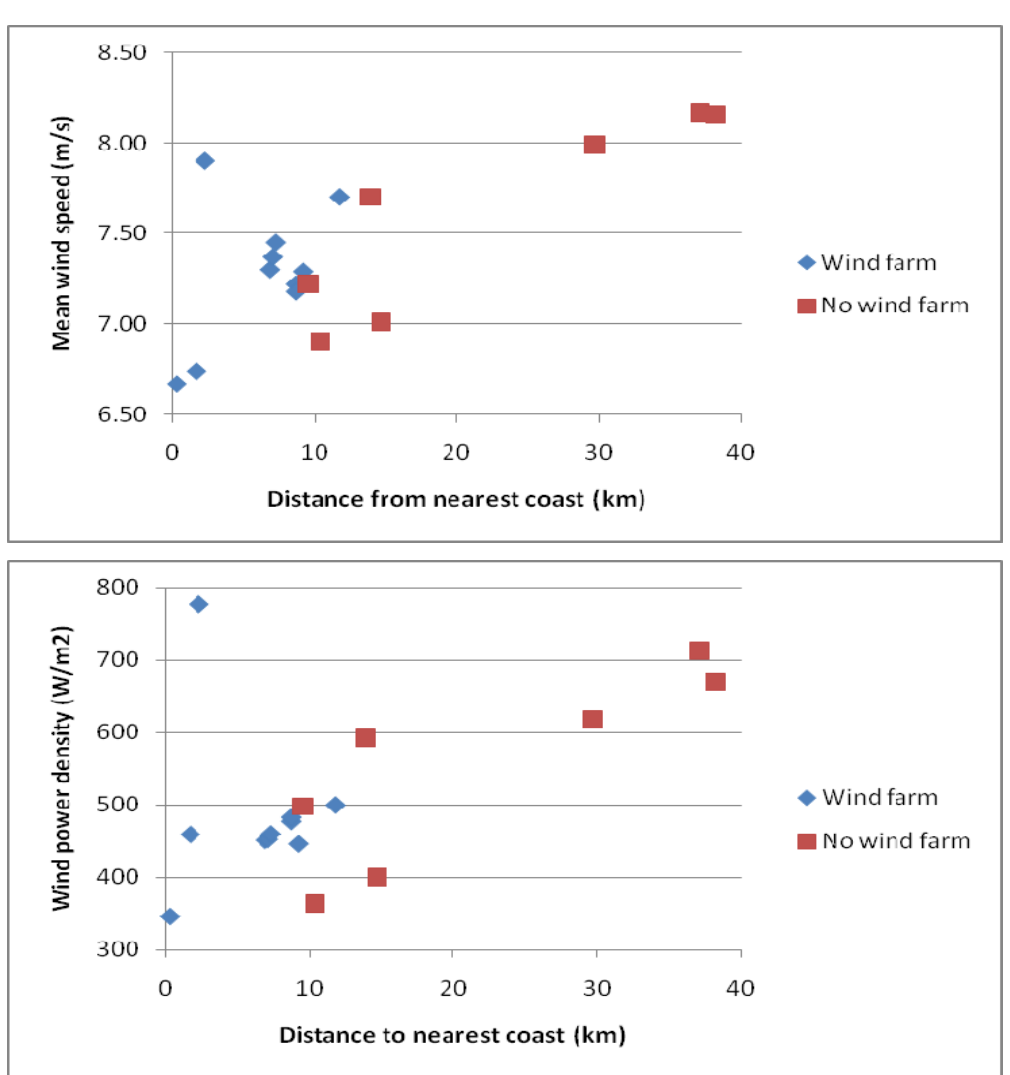
Figure 10. SAR-based mean wind speed (top) and wind power density (bottom) at the location of 17 meteorological masts, near or far from wind